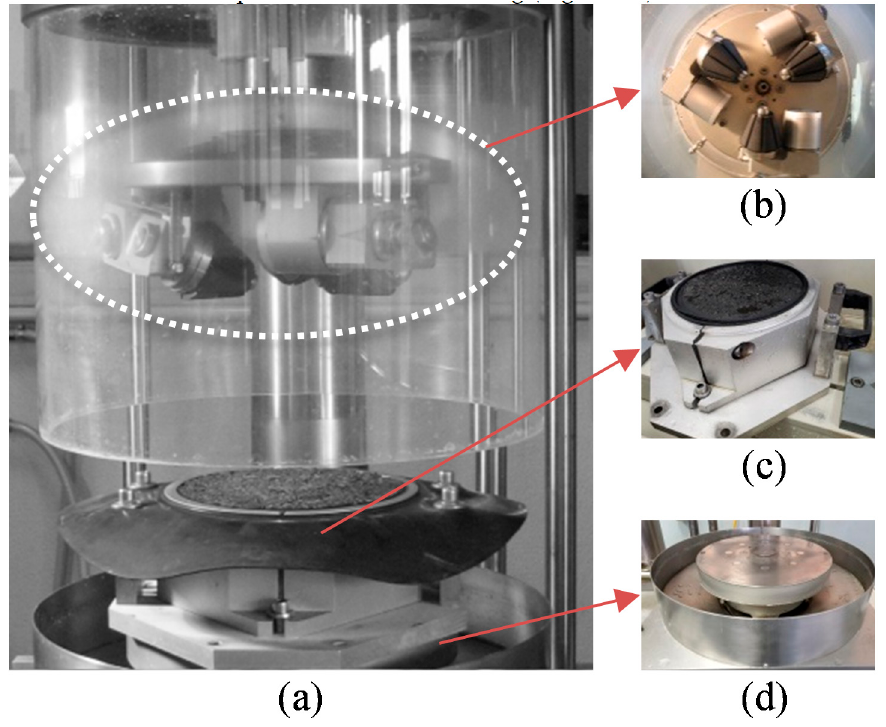
Figure 3. ( a ) Polishing unit; ( b ) rotating head; ( c ) sample holder; ( d ) torque measuring base.